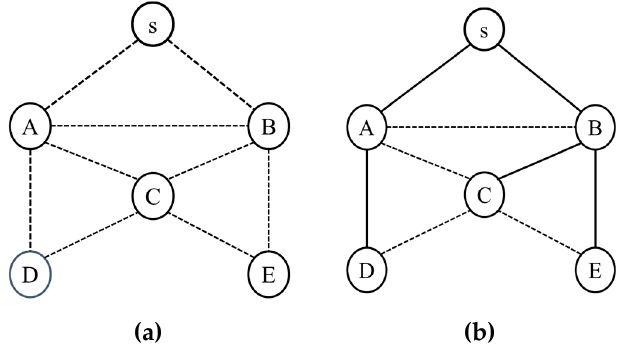
Figure 5. An example network. ( a ) Network before NCP starts, ( b ) Network after NCP finishes. Table 1. Information maintained by the nodes after the network construction period.